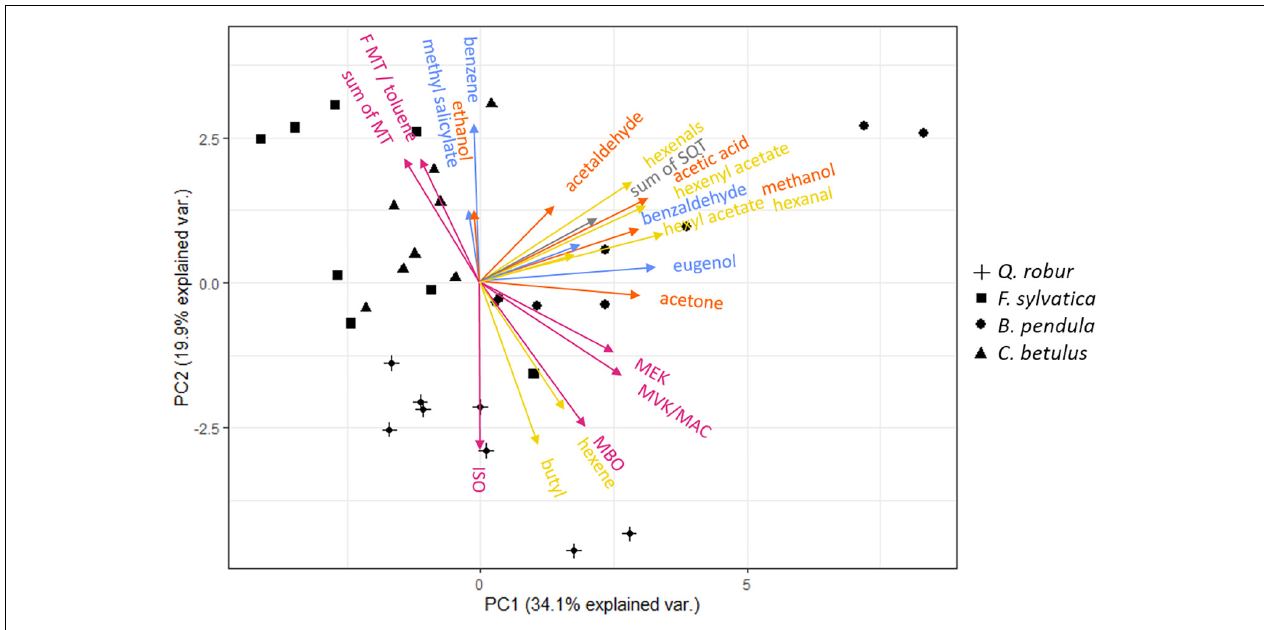
FIGURE 3 | Principal component analysis (PCA) of 22 m/z assigned to constitutive VOC emissions of Q. robur (cross), F. sylvatica (square), B. pendula (circle), and C. betulus (triangle) seedlings. ISO, isoprene; MBO, 2-methyl-3-buten-2-ol; MVK, methyl vinyl ketone; MAC, methacrolein; MEK, methyl ethyl ketone; MT, monoterpenes; SQT, sesquiterpenes. Color-codes indicate VOC related to the LOX (yellow), MEP (magenta), Shikimate (blue), and MVA (gray, i.e., SQT) pathways, and oxygenated VOCs (orange), respectively. See Supplementary Table 4 for PC 1–4 loadings, and Supplementary Figure 2 for species-specific PCAs.